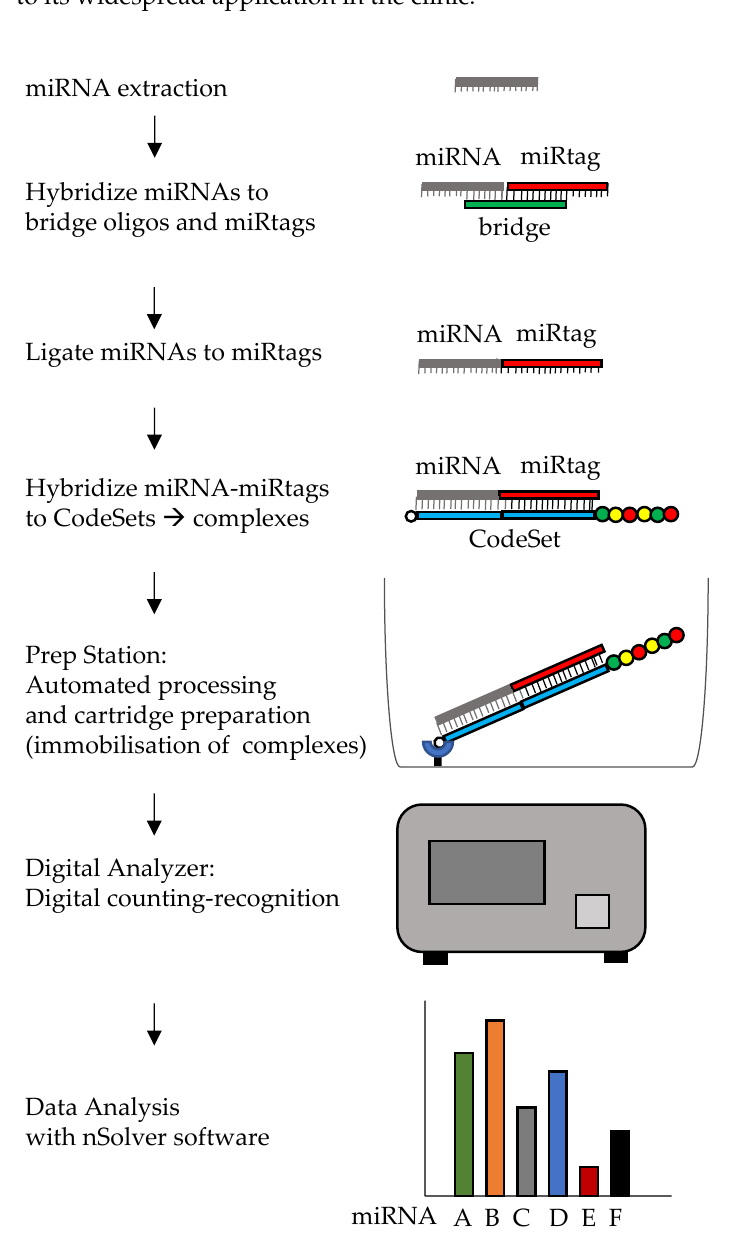
Figure 7. Diagram of Nanostring nCounter workflow. After hybridization with bridge oligos, miRNAs are ligated to miRTags and hybrized to capture and reporter probes (constituting the Codesets): the biotinylated capture probe will be used to immobilize the complexes on the cartridge in the Prep Station, whereas the reporter probes will allow identification and counting of each type of miRNA complex by the Digital Analyzer, by means of a unique code formed by a combination of fluorophores. Wash steps are not